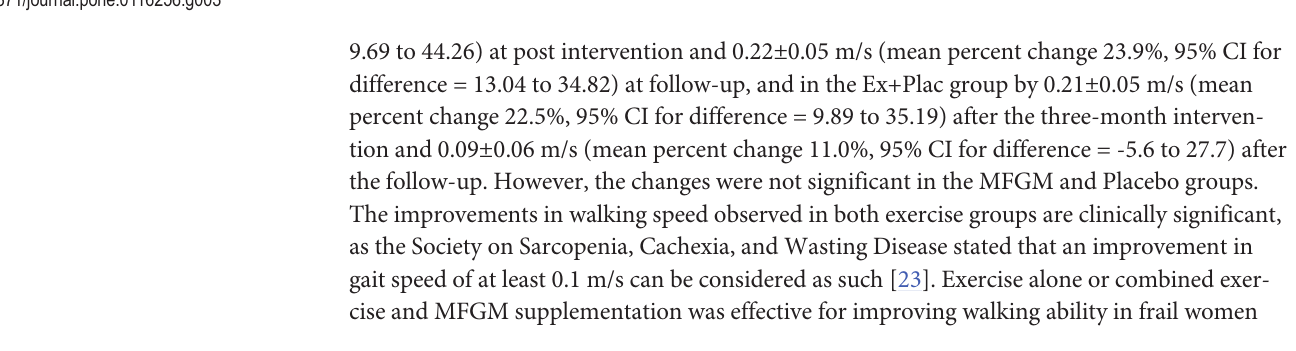
Fig 3. Reversal rates of frailty. Black bar signifies baseline to post-intervention and gray bar signifies baseline and follow-up. Ex = exercise; MFGM = milk fat globule membrane; P = placebo.